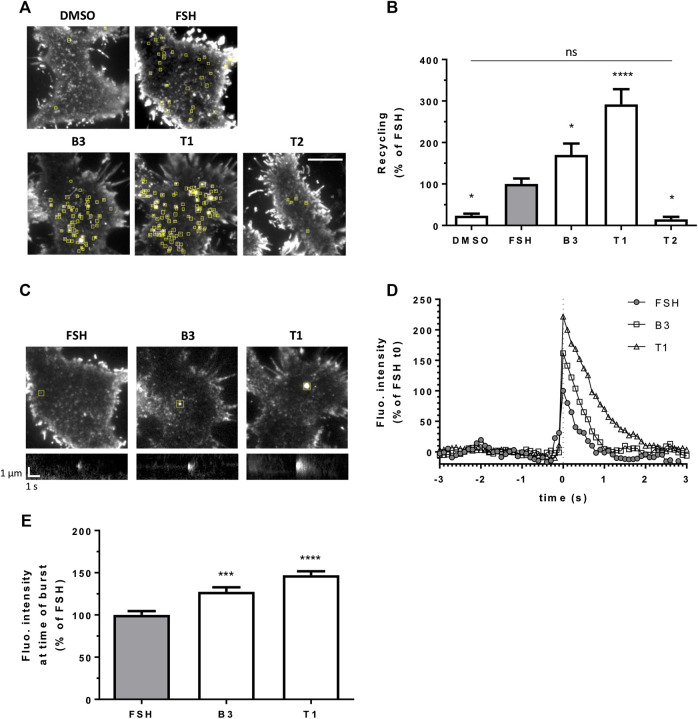
LMW agonists of FSHR induce a greater exocytic rate than FSH. (A) Maximum intensity projections from SEP-FSHR expressing HEK 293 cells imaged live by TIR-FM before and after 5-min stimulation with either DMSO, FSH (10 nM), B3, T1 or T2 (10 μM). Yellow squares indicate exocytic events detected in the corresponding TIR-FM movies (Supplementary Movies S1–S5). Scale bar = 10 μm. (B) Quantification of the number of FSHR exocytic events from (A); n = 7–11 cells/condition collected across at least three independent experiments. One-way ANOVA: *p < 0.05, ****p < 0.0001. (C) Images (top) and kymographs (bottom) of representative FSHR exocytic events (yellow squares) detected after 5-min stimulation with either FSH (10 nM), B3 or T1 (10 μM). (D) Fluorescence intensity of the representative FSHR exocytic events shown in (C). Data represent average fluorescence values within an ROI drawn around each event measured 3 s (30 frames) before and after event burst (t0) minus background fluorescence (= fluorescence measured in the ROI during the 30 frames before event burst (t0) was averaged and subtracted from fluorescence values at each frame); values were normalized considering FSH fluorescence at t0 = 100%. (E) Fluorescence intensity at time of burst of n = 212, 326, and 328 exocytic events from 11, 9 and 9 cells treated with FSH, B3 and T1, respectively, from (B); values represent maximum intensity fluorescence minus background fluorescence in each ROI at time of event burst; values were normalized considering FSH = 100%; Kruskal-Wallis test: ***p < 0.001, ****p < 0.0001.